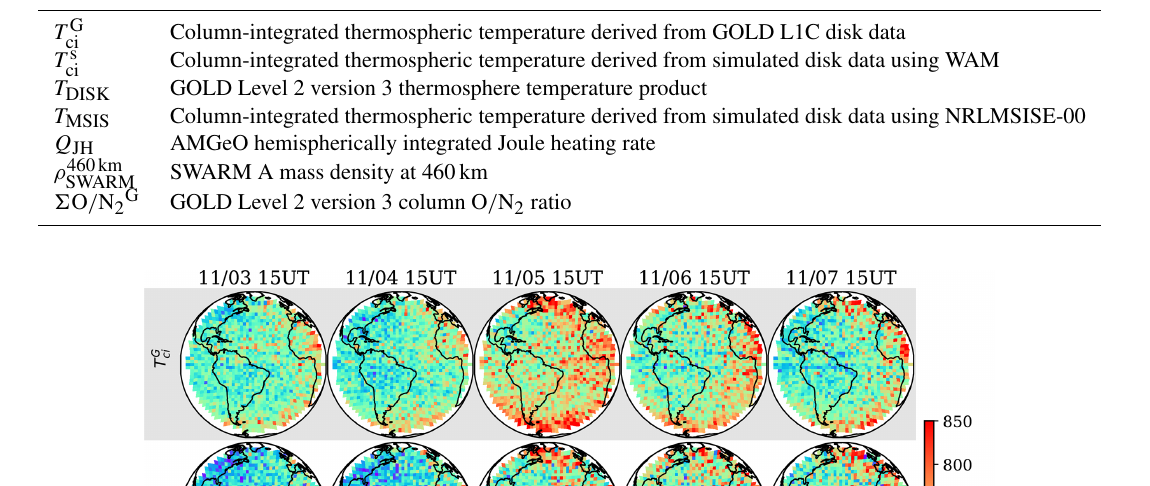
Table 1. Variable definitions.